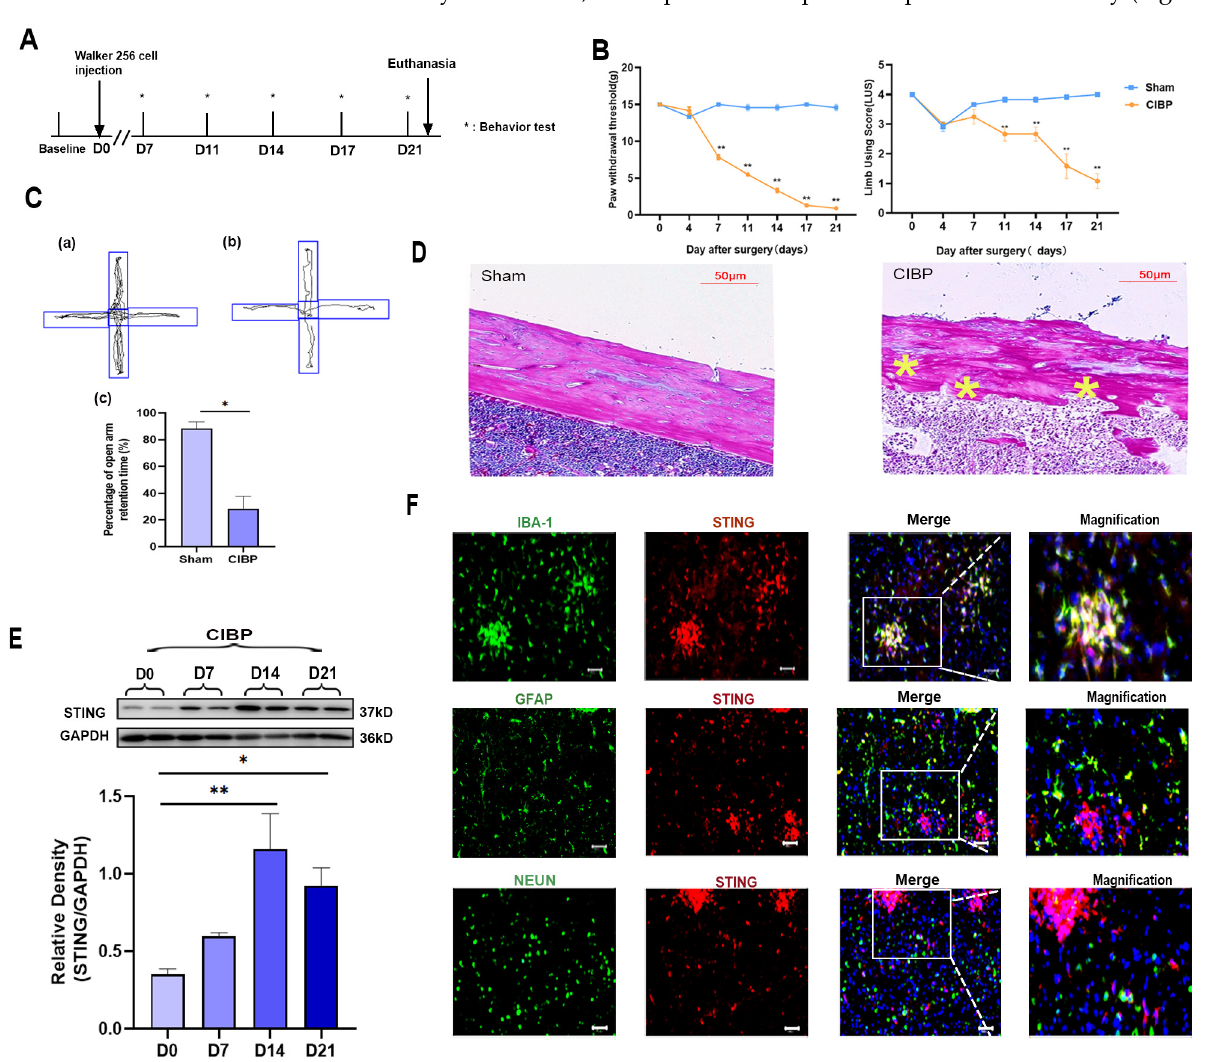
Figure 1. The expression and cellular localization of STING in mPFC of CIBP rats. ( A ) Timeline of the treatment schedule. ( B ) The paw withdrawal threshold (PWT) measured mechanical allodynia (Left). The use of limbs was measured by limb use score (Right), n = 4. ( C ) The tracks and analysis of elevated plus-maze experiment. Representative activity traces of sham ( a ) and CIBP ( b ) in the elevated plus-maze experiment are shown. Percentage of open arm retention time was analyzed ( c ), which was used to measure the degree of anxiety. ( D ) HE staining of tibial on tumor inoculated side. The asterisks are used to mark the areas of bone destruction at day 21 in the CIBP rats. ( E ) The expression of STING at days 0, 7, 14, and 21 was determined using Western blots. GAPDH was detected as an internal control. ( F ) Representative immunofluorescence images of IBA-1 (green), GFAP (green), NEUN (green), and STING (red) in CIBP group rats at day 14. The nuclear was labeled with DAPI (blue), and magnification is shown in the fourth panel. The result showed that STING is mainly located in the microglia of mPFC. Scale bar = 50 µ m. Data are expressed as mean ± S.E.M. n = 4, * p < 0.05, ** p < 0.01 vs. sham group. Full pictures of the Western blots are presented